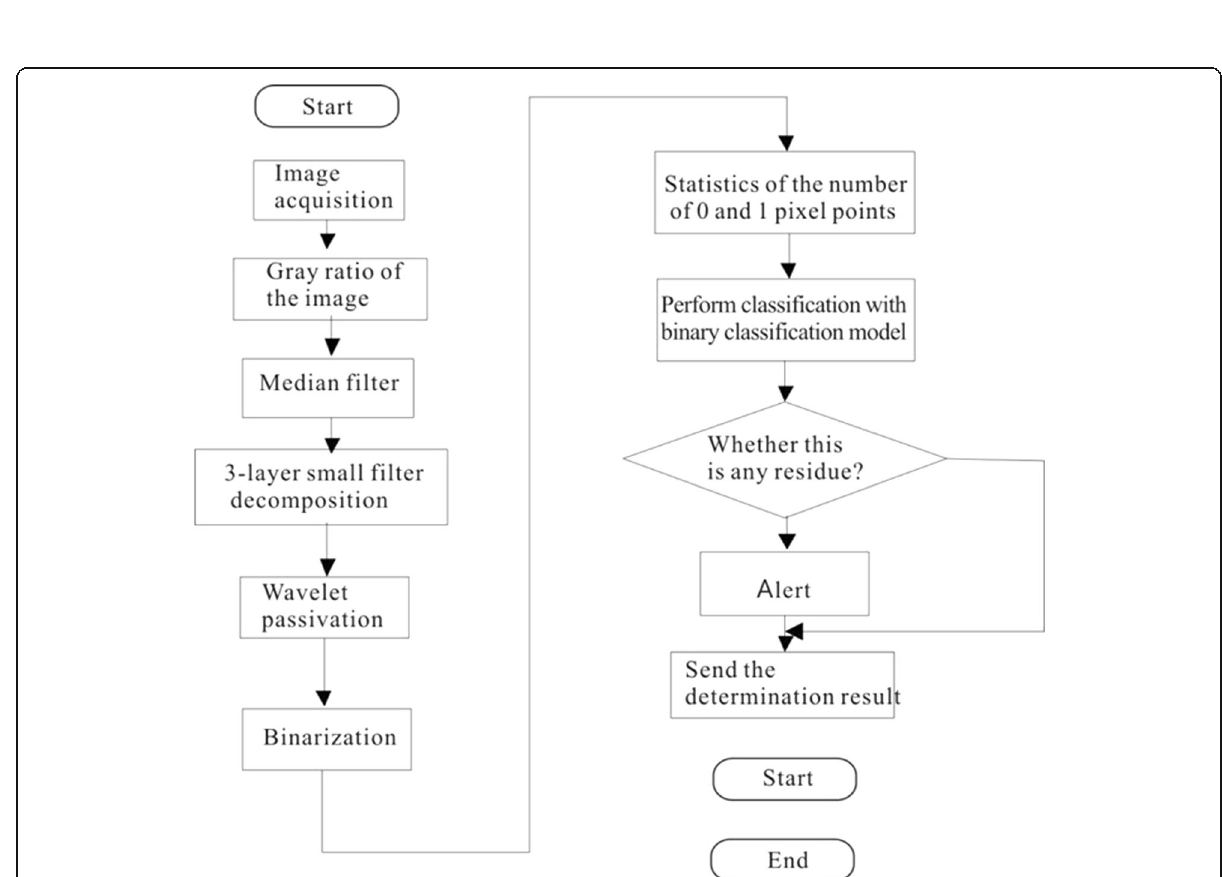
Fig. 4 Flow of algorithm operation mode